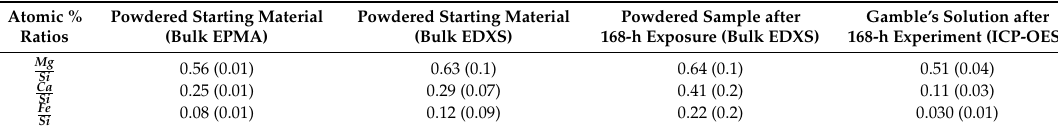
Figure 8. Changes in the concentrations of ( a ) Si and Mg, and ( b ) Ca in Gamble’s solution over time, documenting release of these elements from the powdered sample. The symbol x represents the average values, and error bars show the standard deviation of triplicate experiments. Table 5. Comparison of the elemental ratios in the powdered starting material, in the remaining solid after 168-h exposure to Gamble’s solution, and in Gamble’s solution after 168 h of interaction. Values shown for Gamble’s solution are averages of triplicates with the total error given in parentheses, whereas Energy-Dispersive X-Ray Spectroscopy (EDXS) analyses are averages of 50 individual spot analyses (total error given in